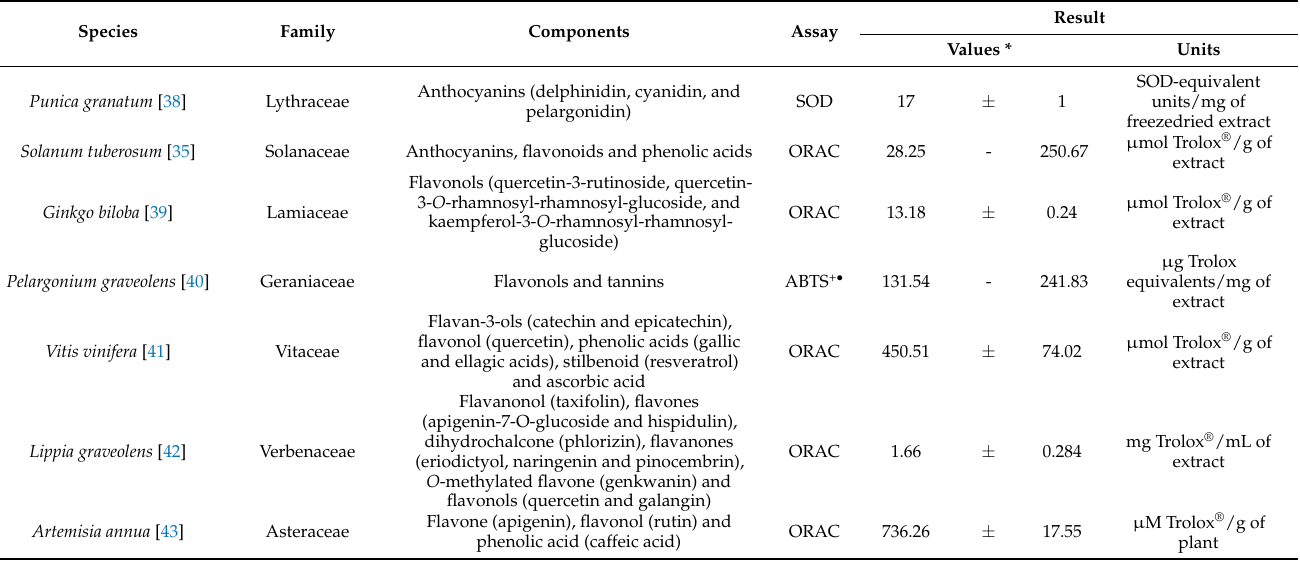
detected, but its isomer, kaempferol-3-glucoside, was confirmed. Table 4. Antioxidant activity of plant extracts with anthocyanins, flavonols, flavan-3-ols, flavanonols and